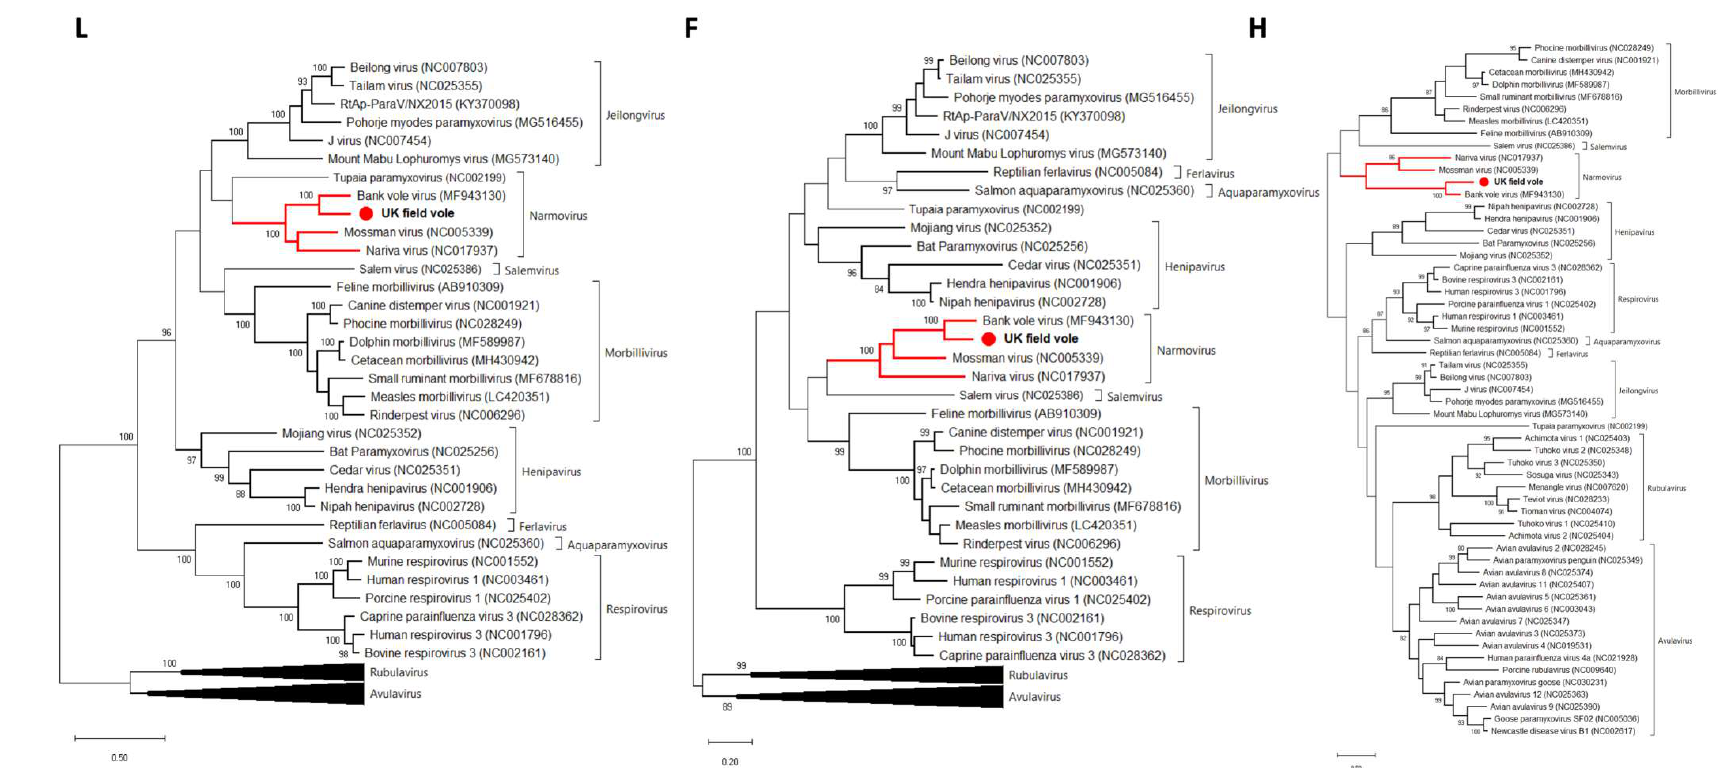
Figure 3. Phylogenetic relationships of the field vole paramyxovirus based on the L , F and H genes. The trees represent maximum likelihood phylogenetic analyses of paramyxovirus partial L (910 aa), F (242 aa) and H (205 aa) gene sequences, revealing that the rodent narmoviruses form a single clade within the Paramyxoviridae . The novel sequence obtained from the UK field vole UK Ma K4D was analyzed alongside reference sequences representing a diverse set of paramyxoviruses. Reference sequences are indicated by their GenBank accession numbers. Branch lengths are drawn to a scale of amino acid substitutions per site. Numbers above individual branches indicate bootstrap support; only values > 80% are shown. Narmoviruses are highlighted in red and the novel UK field vole paramyxovirus is marked with a red dot. For clarity, some large viral clades have been collapsed.